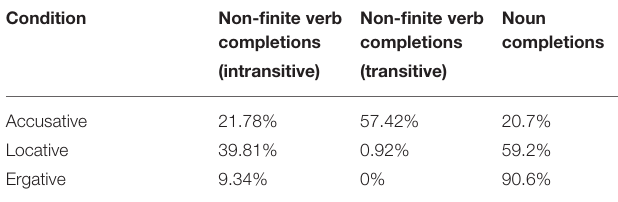
TABLE 8 | Percentage completions of non-finite verbs and nouns in Accusative, Locative and Ergative conditions with no NFV prime in the pilot study (Experiment